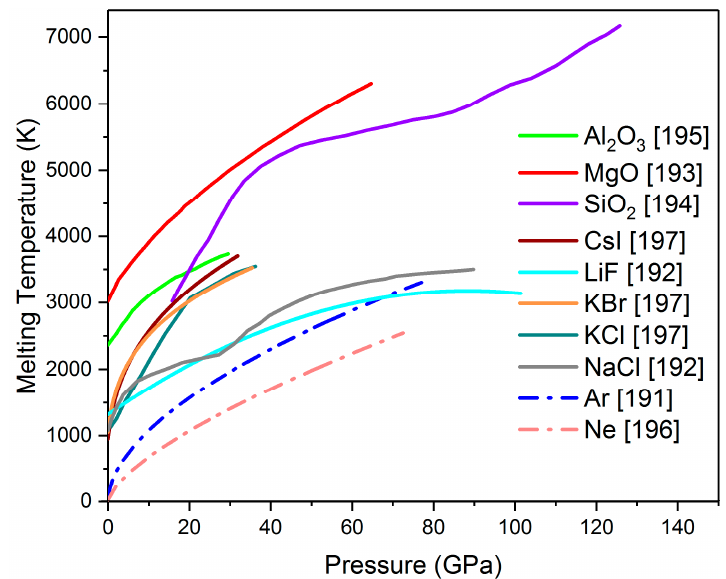
Figure 3. Experimentally defined melting curves of the most commonly used pressure transmitting media (PTMs) inside a laser-heated diamond anvil cell [192–198]. Solid lines: solid PTMs, dash-dotted lines: gas PTMs.